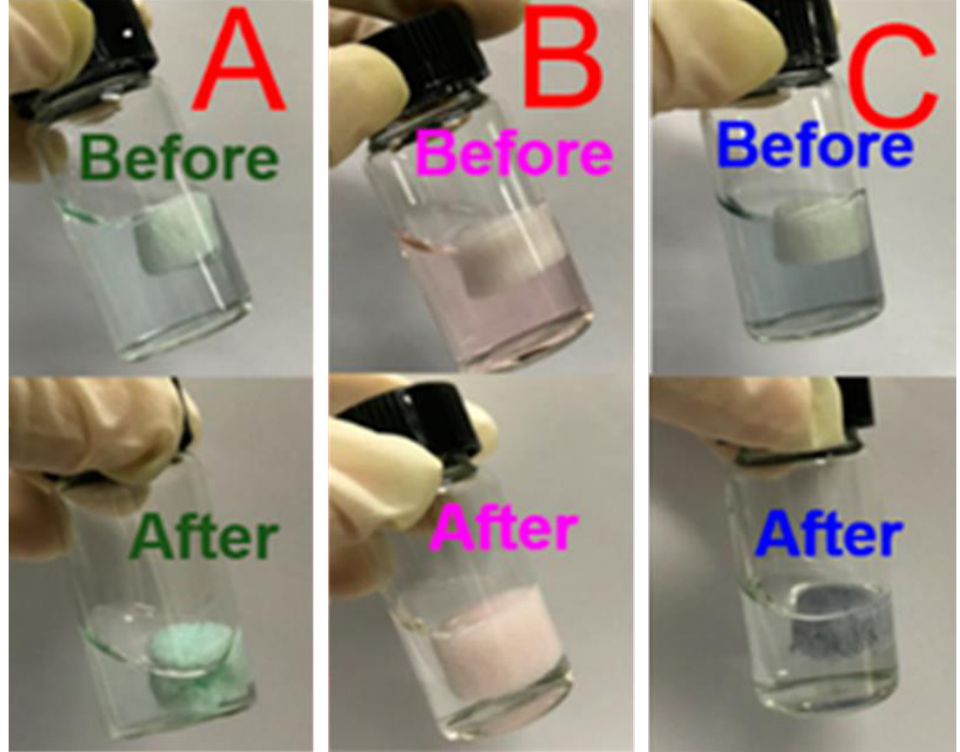
Figure 8. The potential of the prepared absorbers produced based on a metal-organic framework modified by ethylenediaminetetraacetic acid into cellulose nanofiber (CNF) and treated with carboxymethyl cellulose. ( A – C ) depict the prepared absorbers filters’ performance in removing Cu 2+ , Co 2+ , and Cr 3+ , respectively [130].